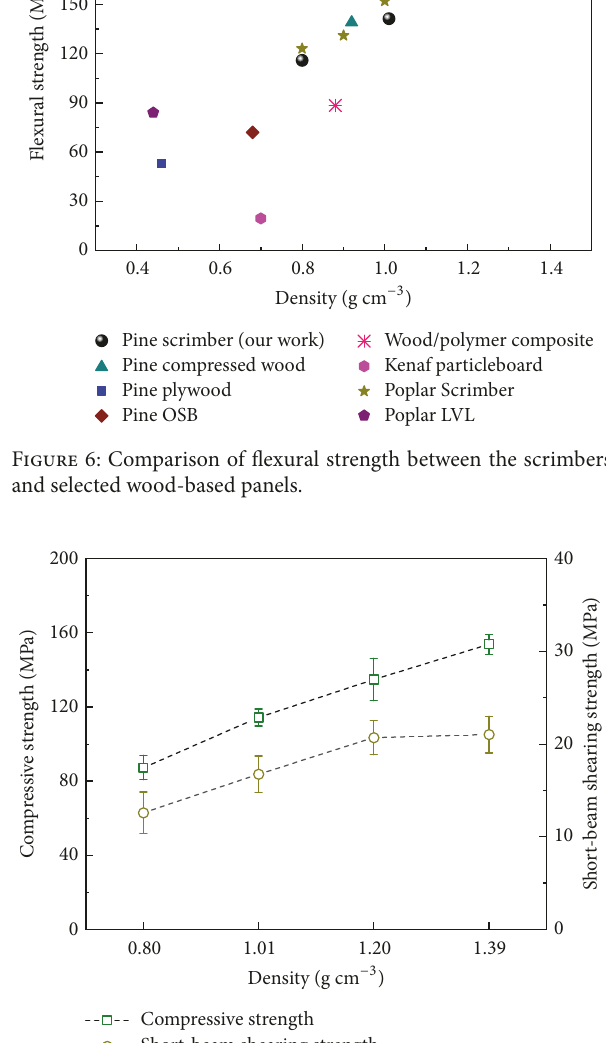
1.01 g cm −3 , the strength surpassed that of pine compressed wood [34]. When the density was equal to 1.39 g cm −3 , MOR was up to 198.92 MPa on average, which was 71% higher than that of scrimers at 0.80 g cm −3 . Meanwhile, the modulus had an increase by about 7.5 GPa in comparison with that at 0.80 g cm −3 .